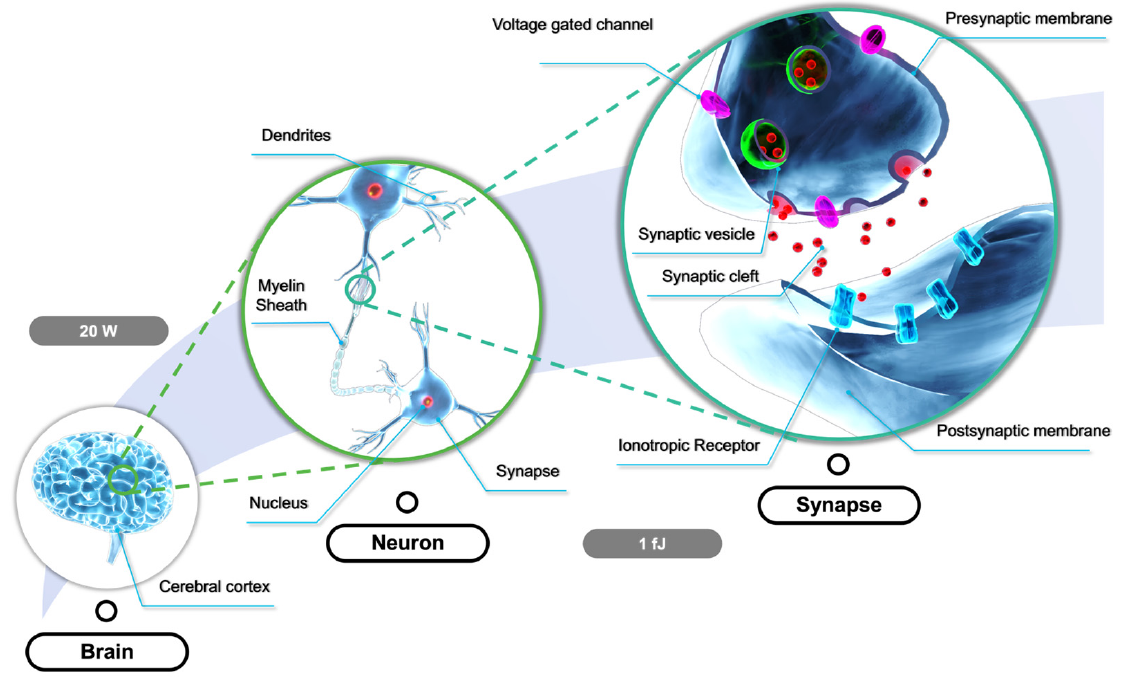
Figure 5. The schematic diagram for biological synapses, which consist of the presynaptic membrane, the synaptic cleft, and the postsynaptic membrane .